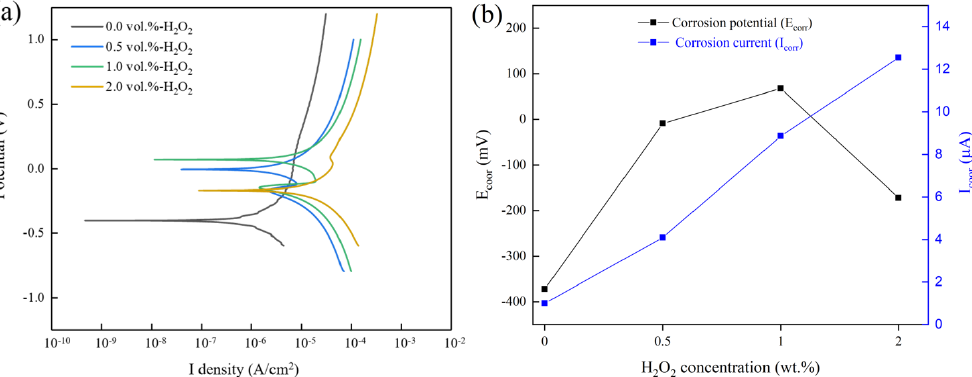
Figure 13. ( a ) Dynamic potential polarization curves at different H 2 O 2 concentration solutions. ( b ) The corrosion potential E corr and the corrosion current density I corr at different H 2 O 2 concentra- tion